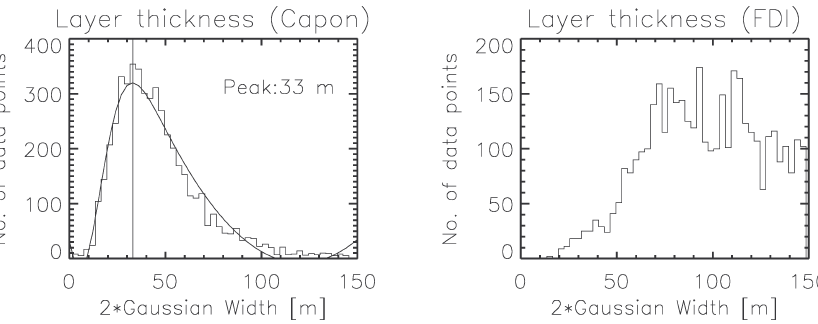
Fig. 8. Comparison between the histograms of thickness distributions estimated from the Capon method (left) and the FDI algorithm (right) for all the available data